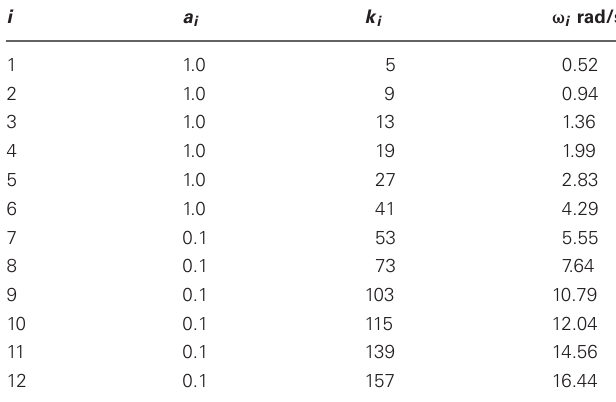
Table 1 | Magnitudes and frequencies used for the input perturbations to the speed of the lead